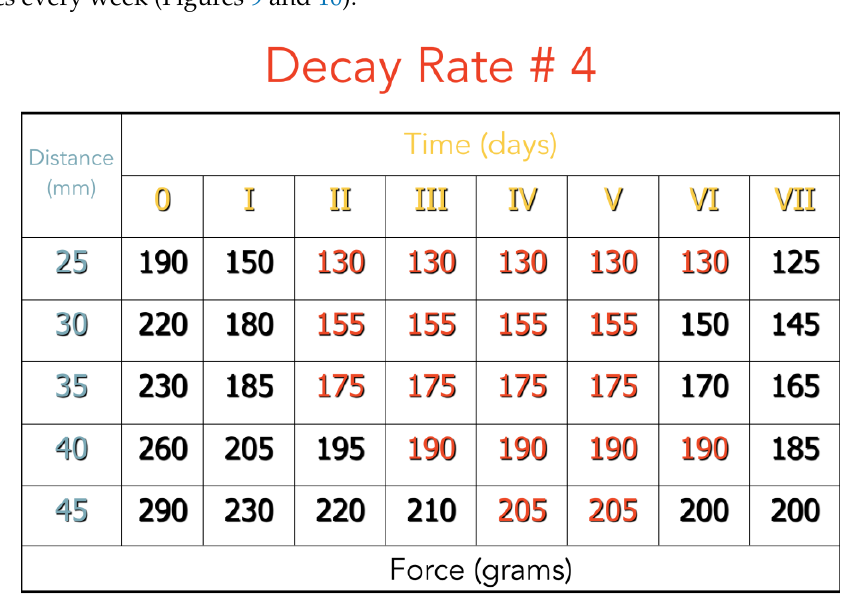
Figure 8. Distance from the lower first molar in the extractive case.